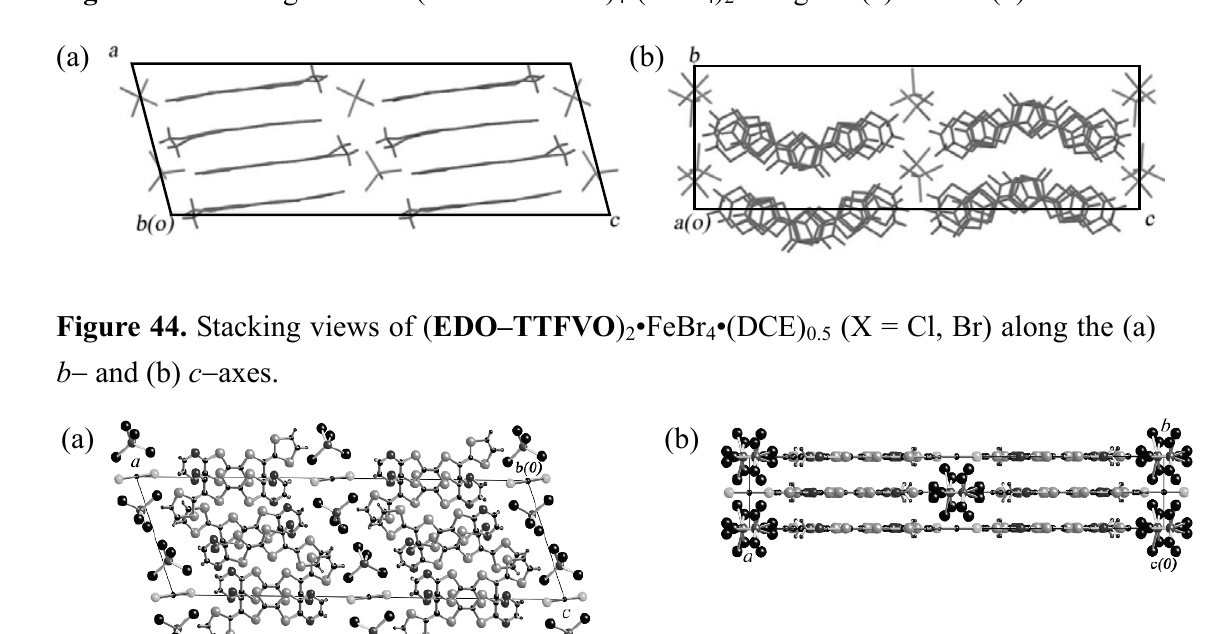
Figure 43. Stacking views of ( EDT–TTFVO )